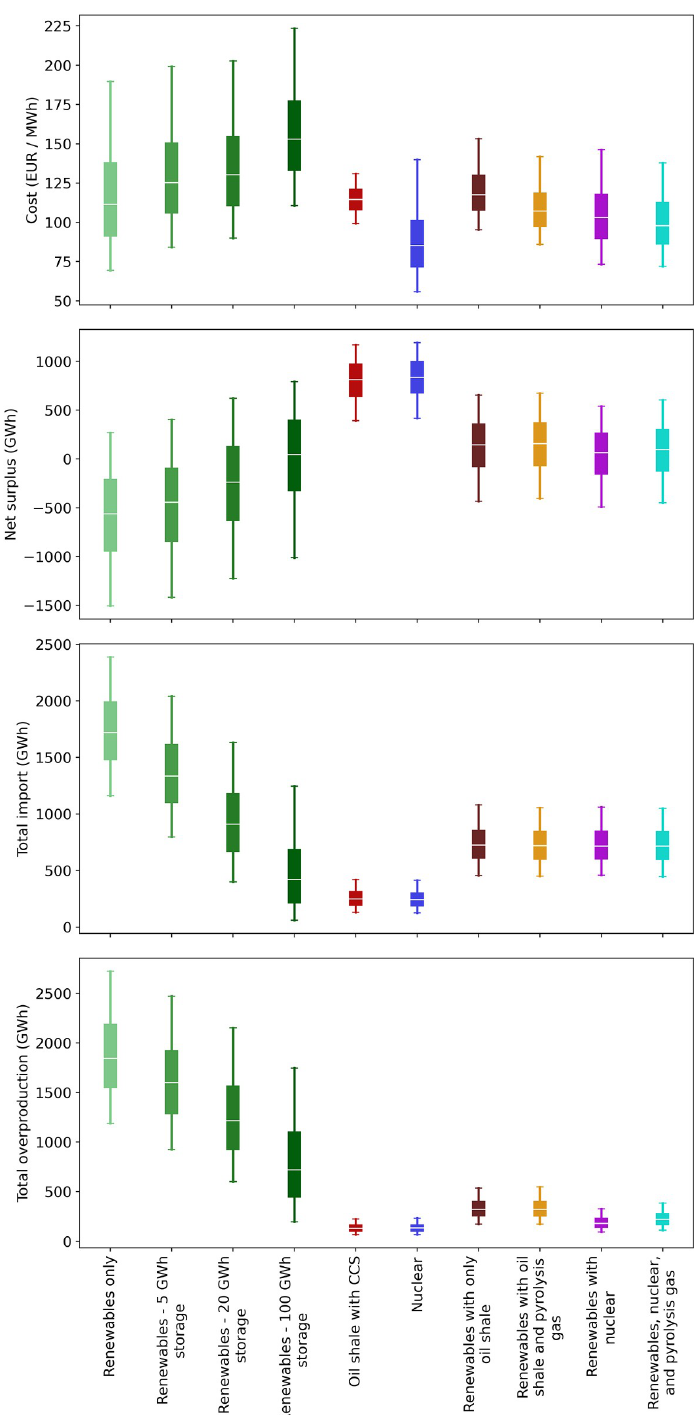
Fig 5. Comparison of different potential energy production scenarios by the levelized cost of electricity and their effect on Estonia’s electricity balance.